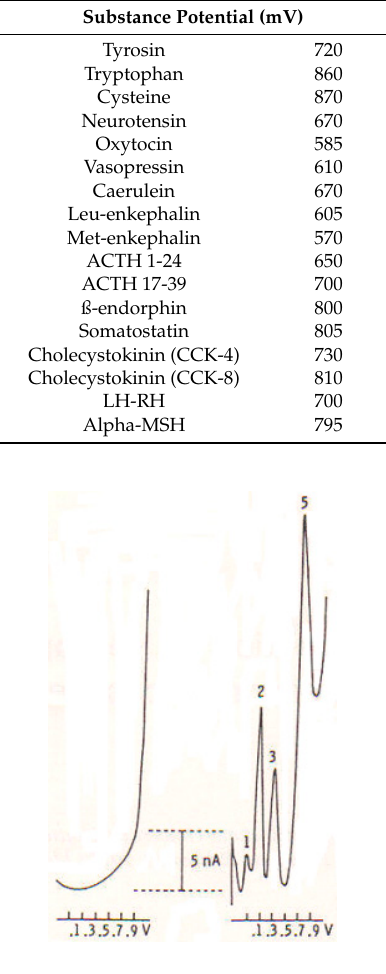
Figure 1. In vitro DPV-µCFE scans obtained in PBS, 0.1 M; pH 7.4 (LEFT) or in a PBS